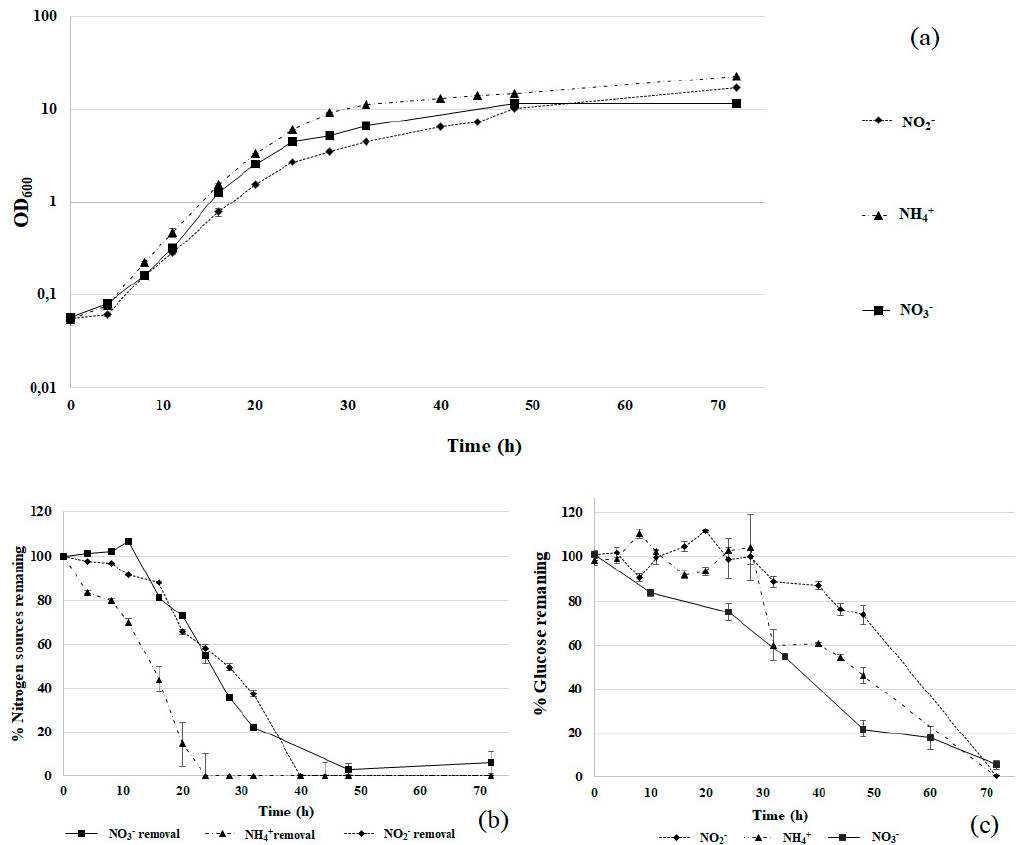
Figure 2. R. diobovata DSBCA06 growth in Yeast Nitrogen Base (YNB) + glucose 2% with different nitrogen sources: 10 mM NaNO 3 , 10 mM NaNO 2 , and 5 mM (NH 4 ) 2 SO 4 (panel ( a )). Nitrogen and glucose removal are reported in panels ( b , c ). OD: optical density at 600 nm.